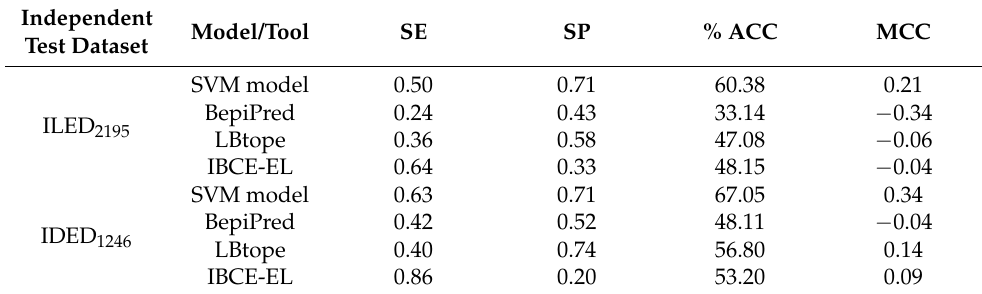
Table 2. Comparitive performance of B cell epitope prediction